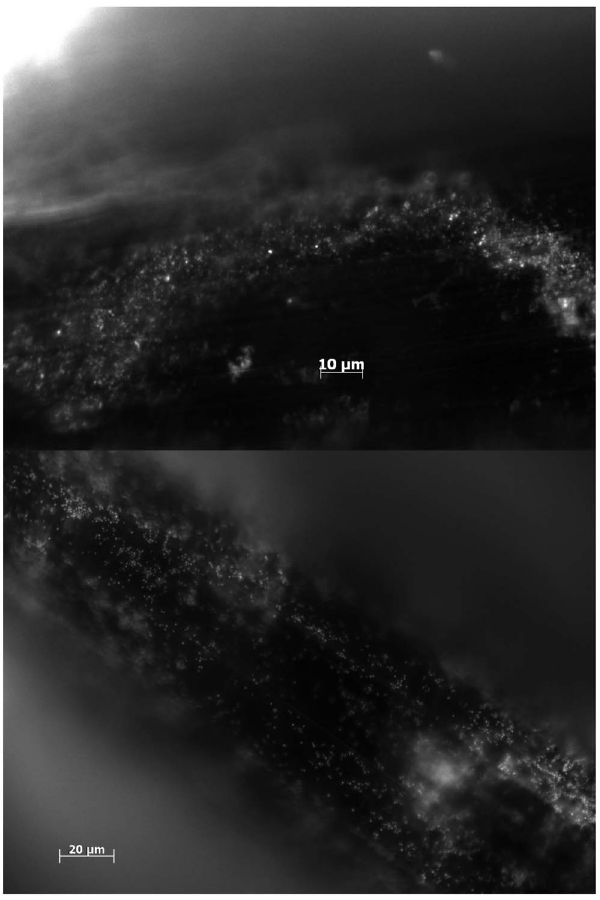
Figure 1. Biofilm assesment with epifluorescence microscopy. Figure 1A shows Xen29 biofilm formation by day 6 post implantation. Implants are washed in saline and stained with DAPI. Along the surface of the implant, clusters of coccoid cells with a diameter of 1 m m are found. The morphology of these cells are consistant with Staphylococ- cus aureus. Figure 1B shows a sterile implant 14 days post implantation.